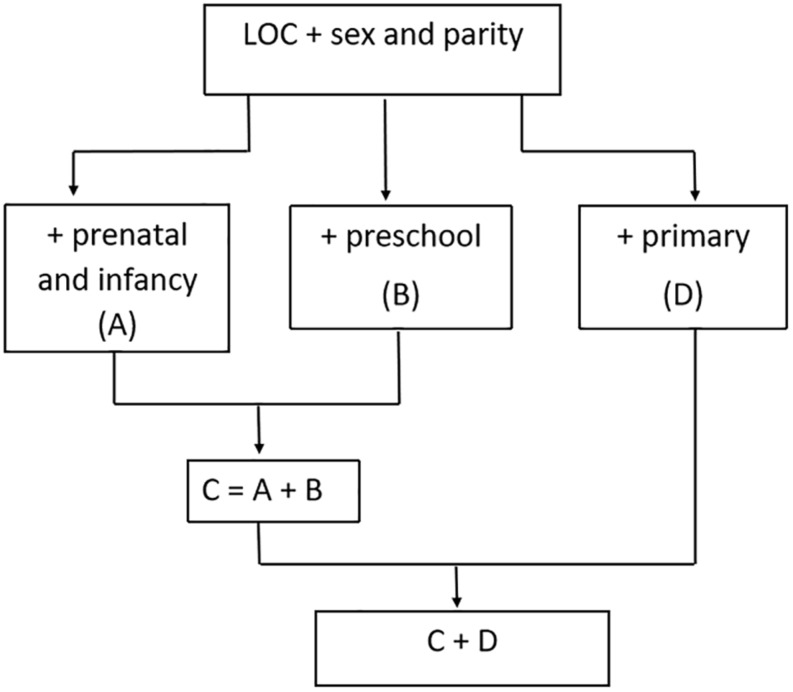
Analytic strategy.